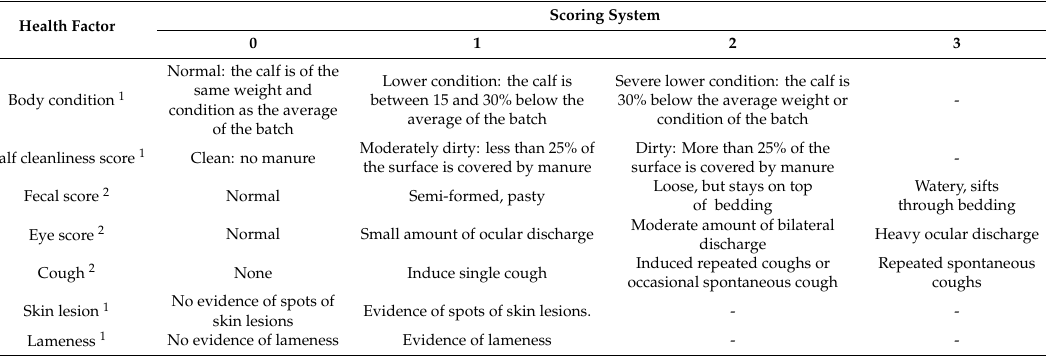
Table 1. Calf health scoring criteria to categorize calves according to its health status on 29 dairy farms using group pens in Los R í os region,